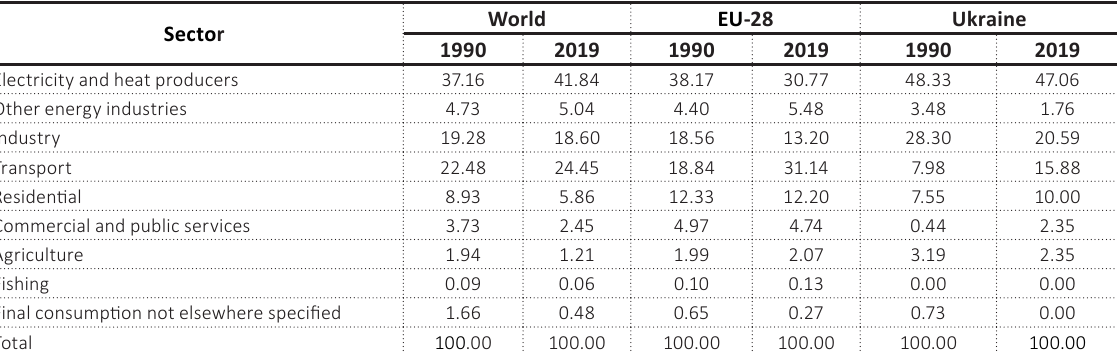
Source: Calculated based on IEA